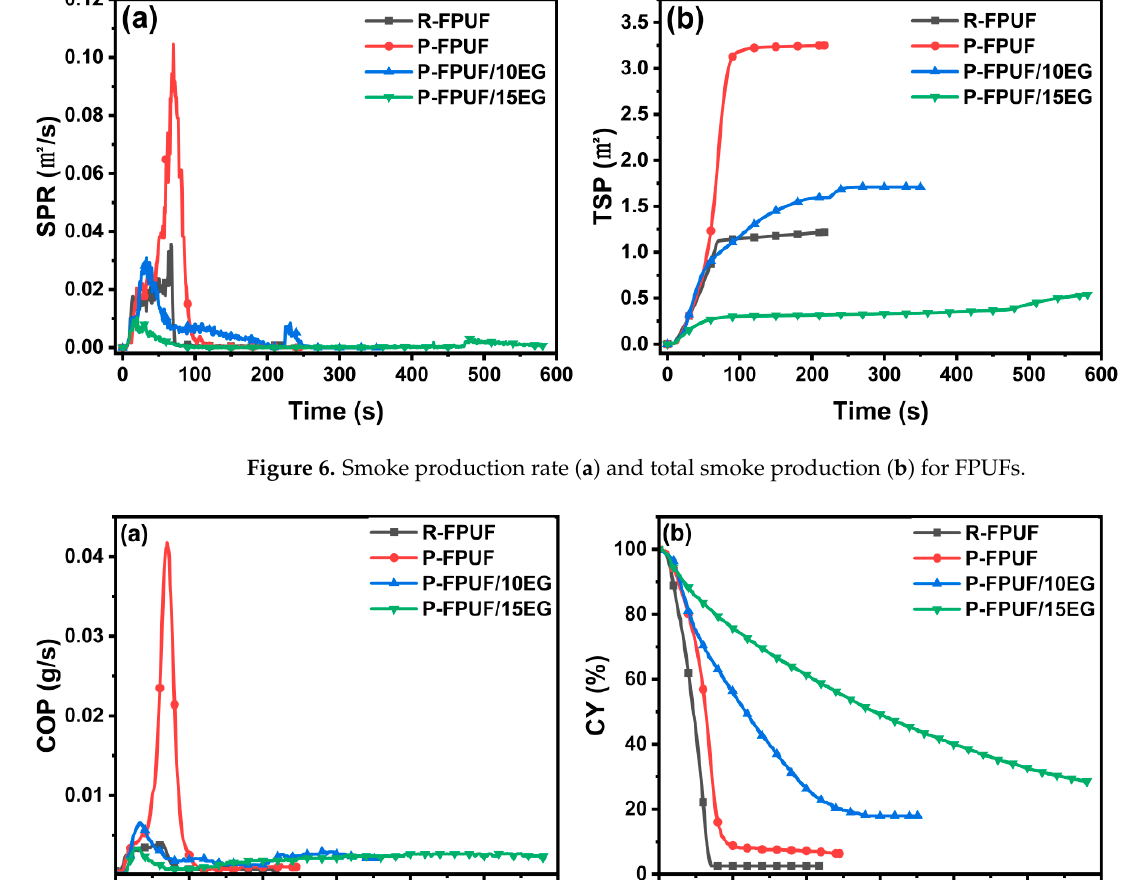
Figure 5. Heat release rate ( a ) and total heat release ( b ) curves for FPUFs under an external heat flux of 25 kW/m 2 .